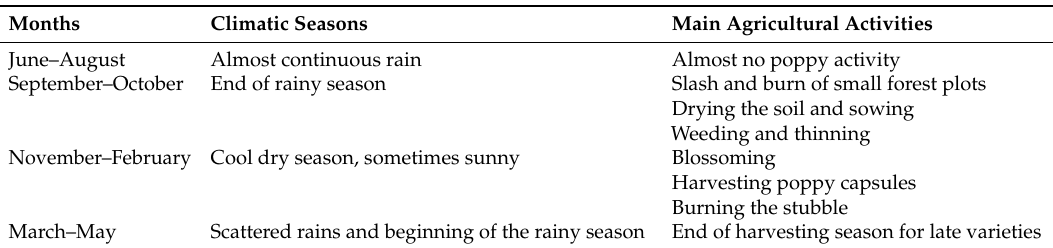
Table 1. Poppy calendar for North Lao PDR.